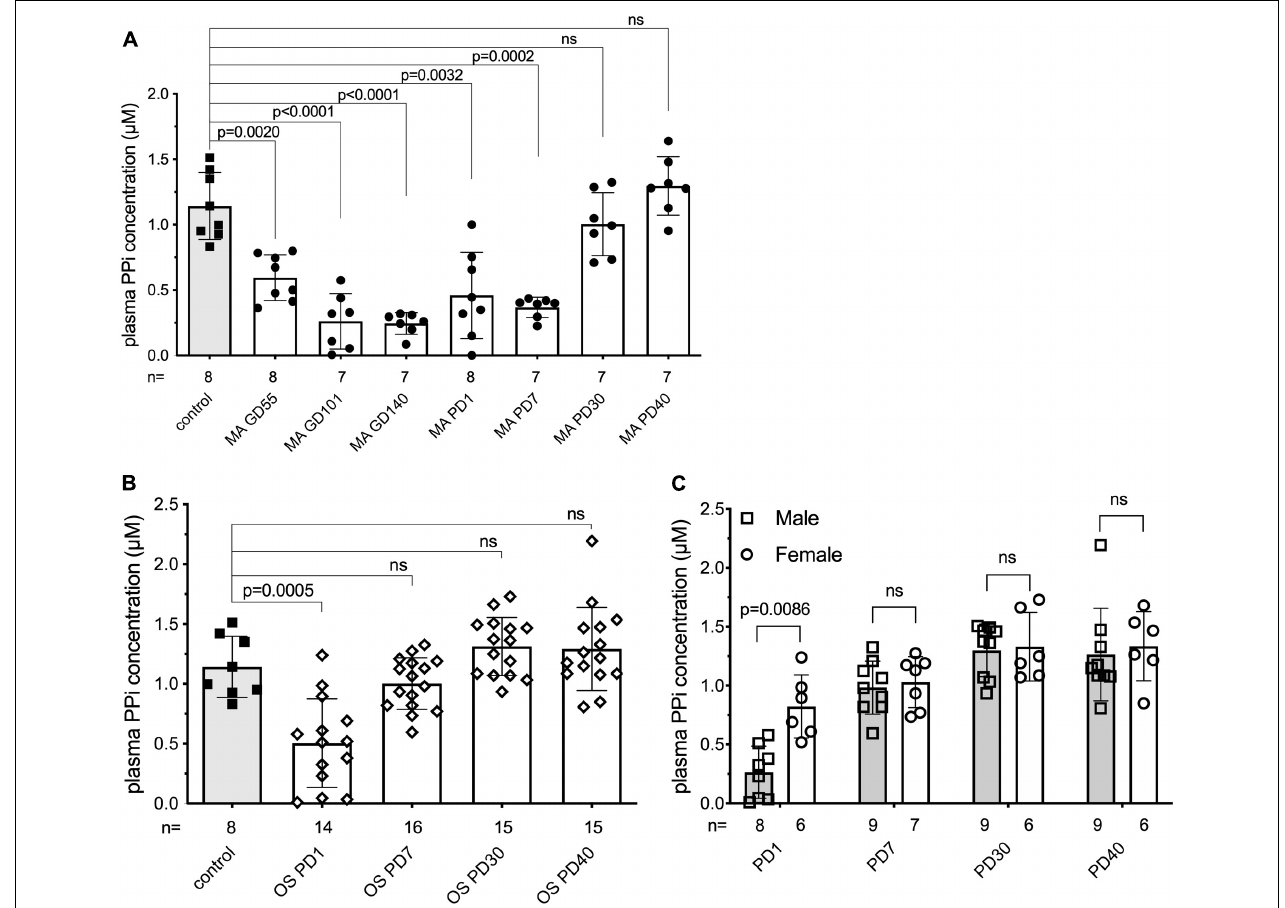
FIGURE 1 | Plasma inorganic pyrophosphate changes dynamically in sheep pre- and postpartum. (A) Plasma inorganic pyrophosphate concentration of pregnant sheep between gestational day 55 and postpartum day 40 ( n = 8, closed circles, white bars) compared to non-pregnant adult females ( n = 8, closed squares, gray bar). (B) Plasma inorganic pyrophosphate concentration of lambs born from sheep in panel (A) between postnatal day 1–40 (weaning) ( n = 16, open diamonds, white bars) compared to the non-pregnant adult females ( n = 8, closed squares, gray bar, from panel A ). (C) Plasma inorganic pyrophosphate concentration of male ( n = 9, open squares, gray bars) and female ( n = 7, open circles, white bars) lambs from panel (B) . MA, mother; OS, offspring; GD, gestational day; PD, postpartum/postnatal day. Values for the data depicted were determined in experiments using at least three technical replicates. Data were analyzed using GraphPad Prism 8.3.0. Animal groups were compared using multiple comparisons of the paired data with mixed effect models not assuming sphericity. Concomitant Sidak’s multiple comparison tests were performed to assess significance. A female lamb was euthanized at postnatal day 15, due to a reason unrelated to the study. Samples that showed hemolysis were not processed further and excluded from the evaluation. The exact number of samples determined for each timepoint are presented under the corresponding bars. Data values are represented as means ± SD. Significance was accepted at p < 0.05. PPi, inorganic pyrophosphate.